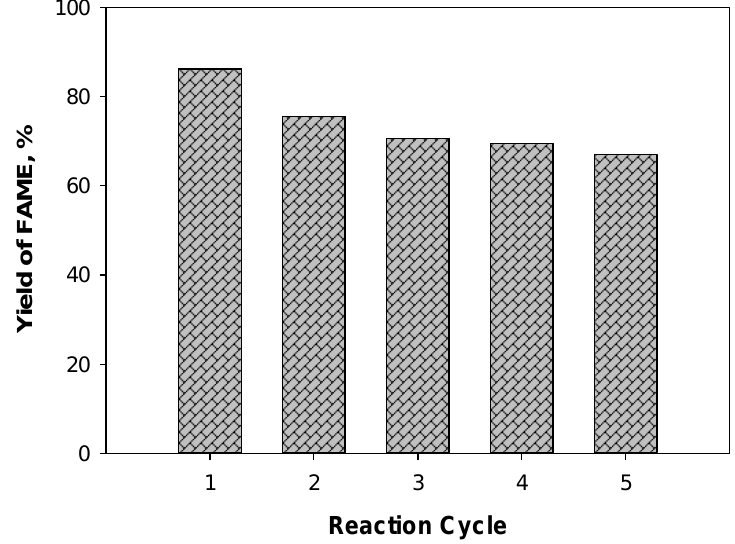
Figure 8. The decreasing activity of the CaO / PMFA-900-600 catalyst observed after each cycle of the 3-h transesterification (at 70 °C, methanol to oil molar ratio of 6:11, and catalyst weight of 6 wt.%).